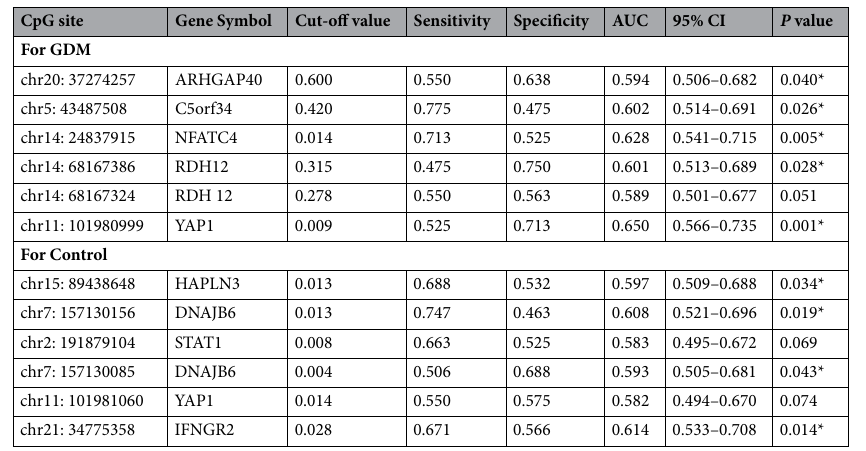
Table 3. The AUC and cut-off value of CpG site DNA methylation. * P < 0.05.